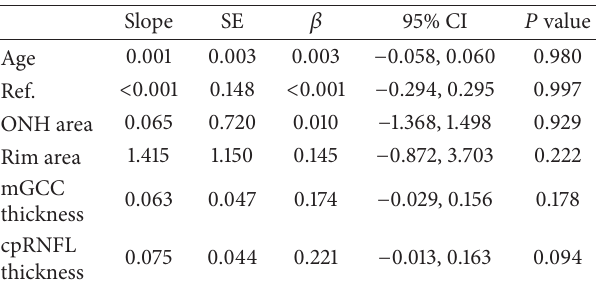
Table 5: Multiple regression analysis for the relationship between MD and other